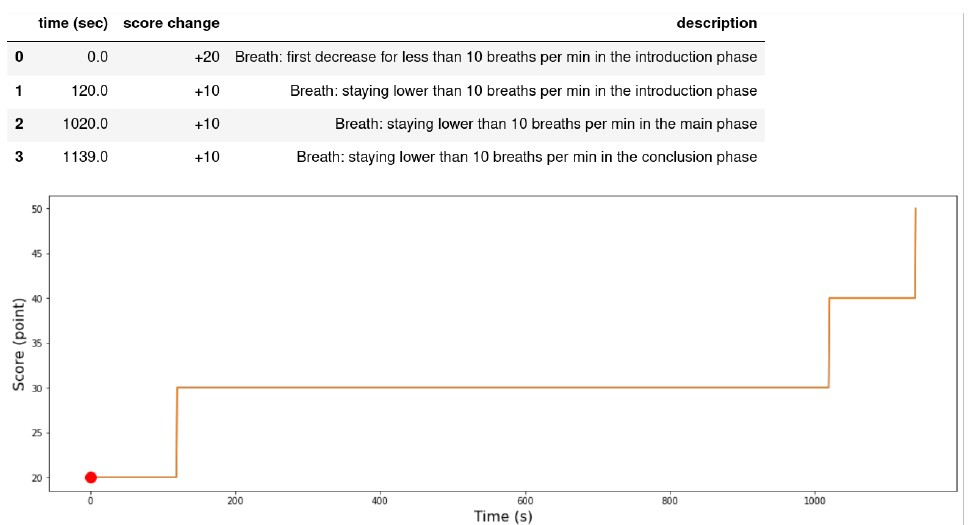
Figure 17. Meditation evaluation for a professional